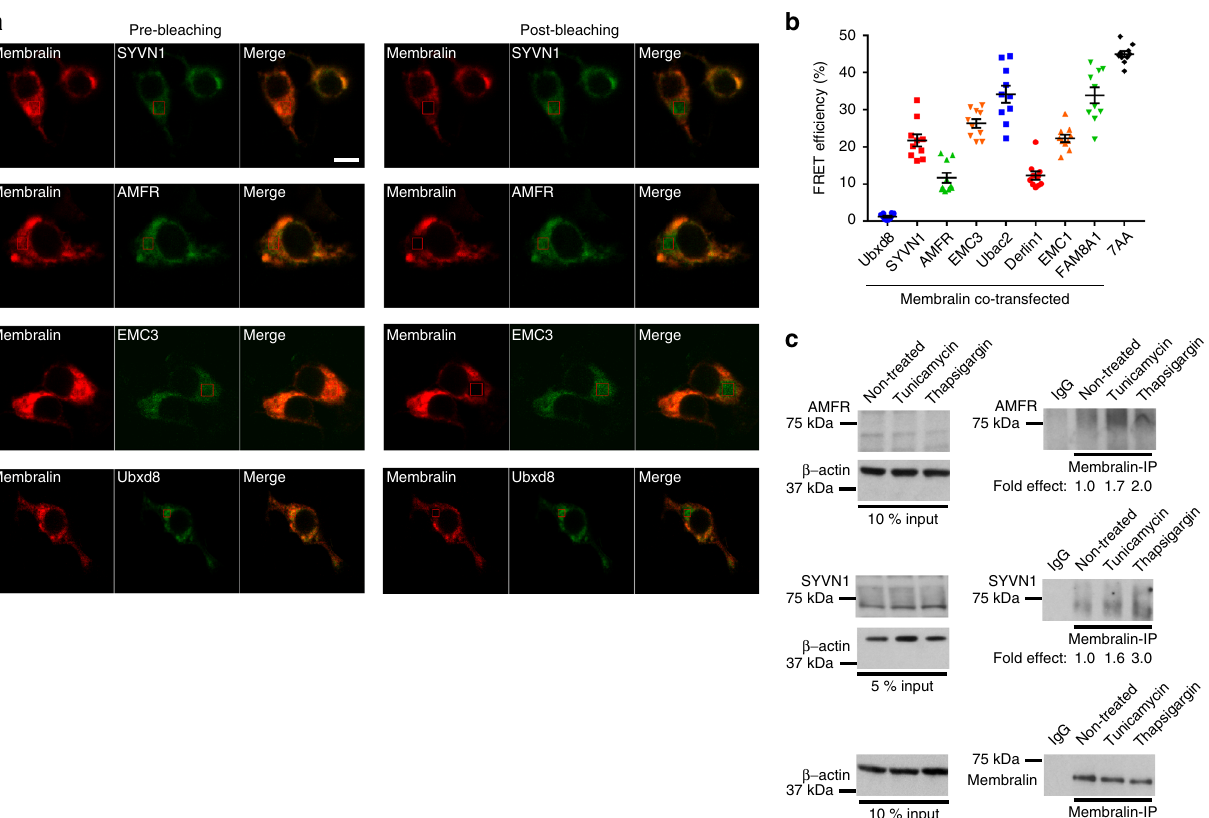
Fig. 2 Con fi rmation of membralin-interacting protein components by FRET and co-IP. a FRET images of cells co-transfected with vectors expressing membralin-mCherry and either SYVN1-EGFP, AMFR-EGFP, EMC3-EGFP or Ubxd8-EGFP. Scale bar, 10 µ m. b Quanti fi cation of FRET ef fi ciency between membralin and SYVN1, AMFR, EMC3, Ubxd8, Derlin1, EMC1, Ubac2, FAM8A1, respectively. mCherry-7AA-EGFP was used as a positive control ( n = 10 cells). Data represent mean ± s.e.m. from three independent experiments. c Co-IP analysis of endogenous membralin interactions with endogenous SYVN1, or AMFR in N2a cells under normal and ER stress conditions induced by tunicamycin (5 μ g/ml) or thapsigargin (500 nM) for 4 hrs. The fold effect shown was calculated using the ratio from AMFR or SYVN1 (IP/Input) normalized to the membralin IP (IP/ β -actin). Non-treated cell samples were set to